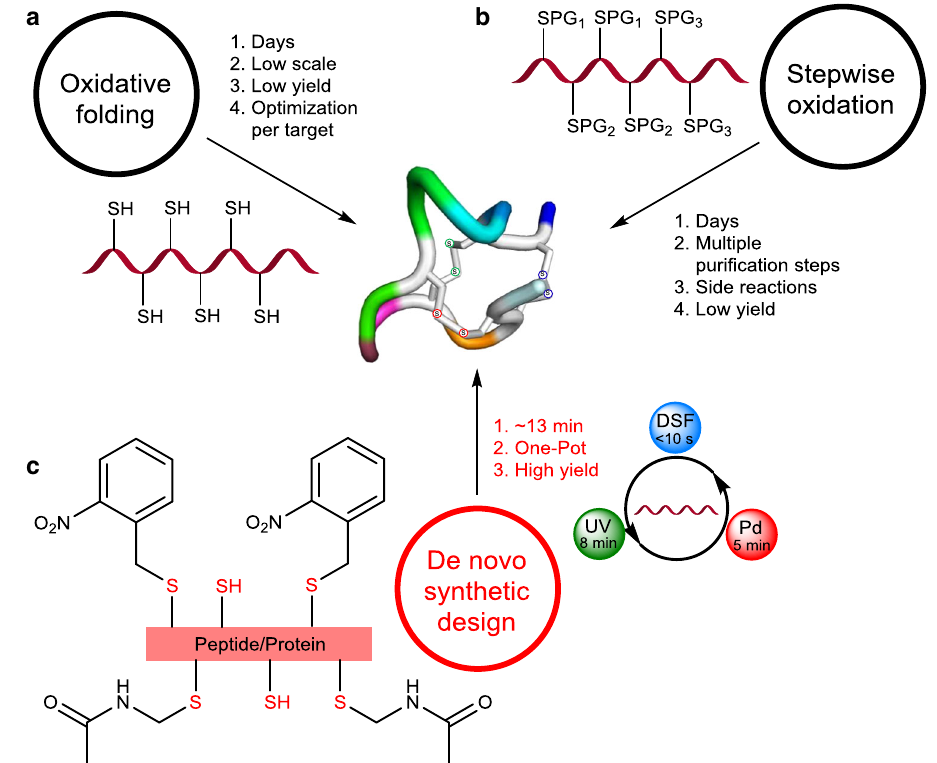
Fig. 1 Prior strategies and our synthetic design for the synthesis of peptides and proteins with three disul fi de bonds. a Oxidative folding under thermodynamic control, main limitations. b Stepwise deprotection and oxidation strategy, main limitations. c Ultrafast high-yielding formation of multiple disul fi de bonds via our strategy (PG is abbreviation for protecting group, UV is abbreviation for ultraviolet-light and DSF is abbreviation for disul fi